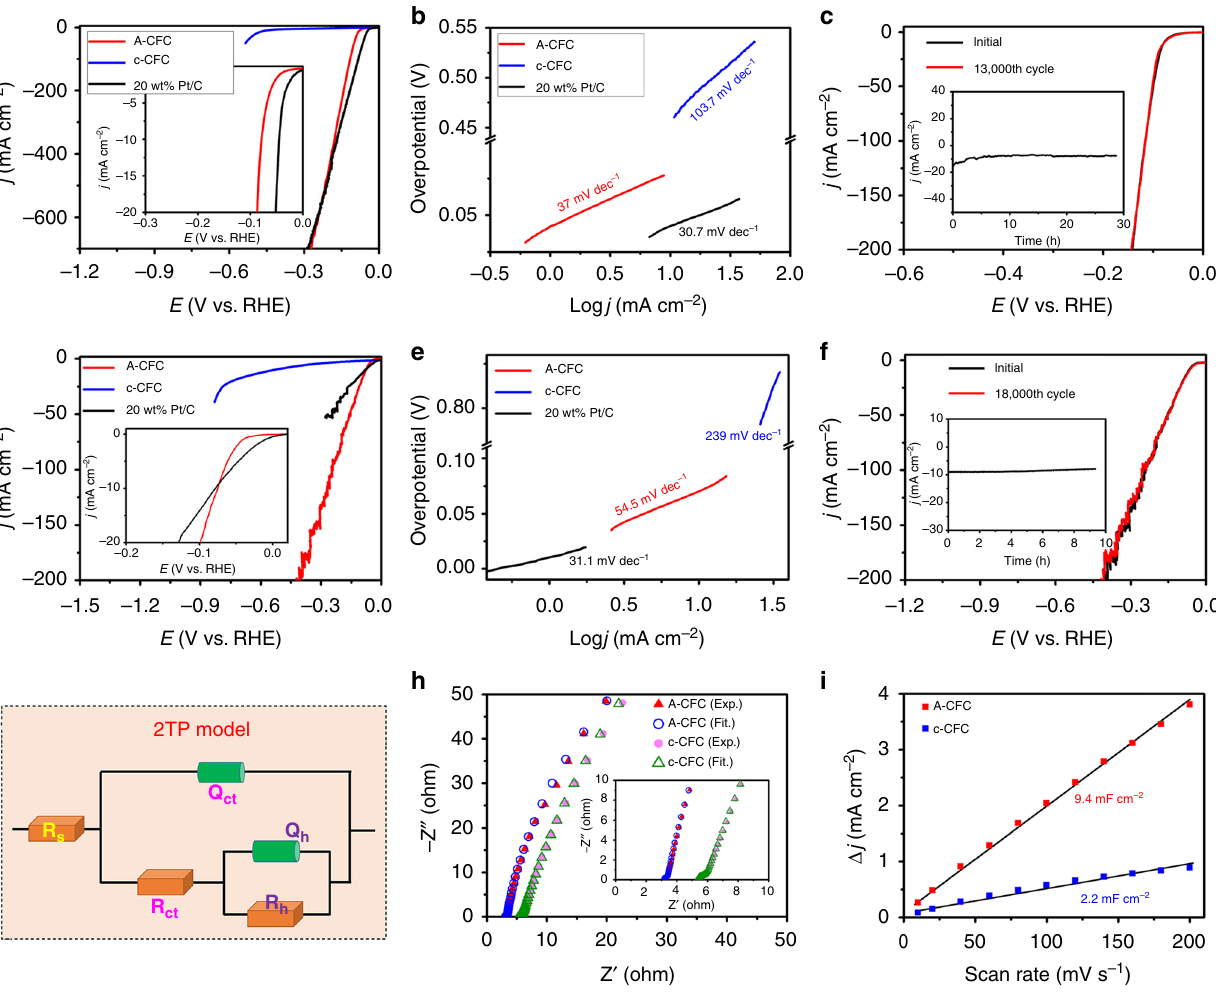
Fig. 5 HER performance of A-CFC. HER polarization curves of catalysts obtained in a 0.5 M H 2 SO 4 and d 1.0 M KOH; b , e corresponding Tafel plots of a , d ; c The polarization curves of A-CFC obtained before and after 13,000 cycling test in 0.5 M H 2 SO 4 (inset: current density-time curve of A-CFC in 0.5 M H 2 SO 4 ); f The polarization curves of A-CFC obtained before and after 18,000 cycling test in 1.0 M KOH (inset: current density-time curve of A-CFC in 1.0 M KOH); g The equivalent circuit model; h Electrochemical impedance plots and i double layer capacitance for the as-synthesized samples (inset in h : enlargement of the high frequency